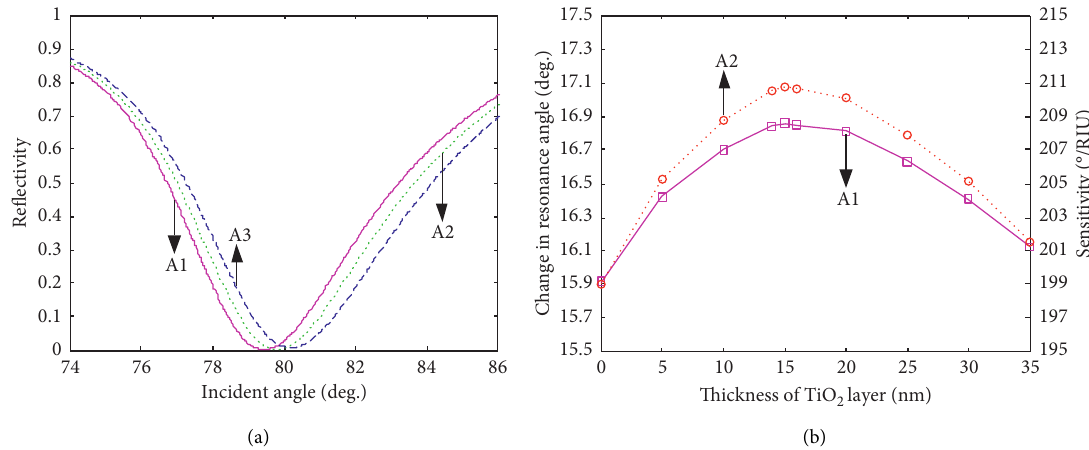
Figure 5: (a) SPR spectrum for different thicknesses of TiO � 10nm (curves A1), 15nm (curves A2), and 20nm (curves A3), as 2 layer for d the case of n � 1.36 for sensing medium. (b) Relationship between the change in resonance angle (curves A1), sensitivity (curves A2), and the thickness of TiO 2 layers. The thickness is 40nm, 46nm, 1 × 0.65nm, and 3 × 1.6nm for ZnO, Au, MoS 2 , and GO layer, respectively.